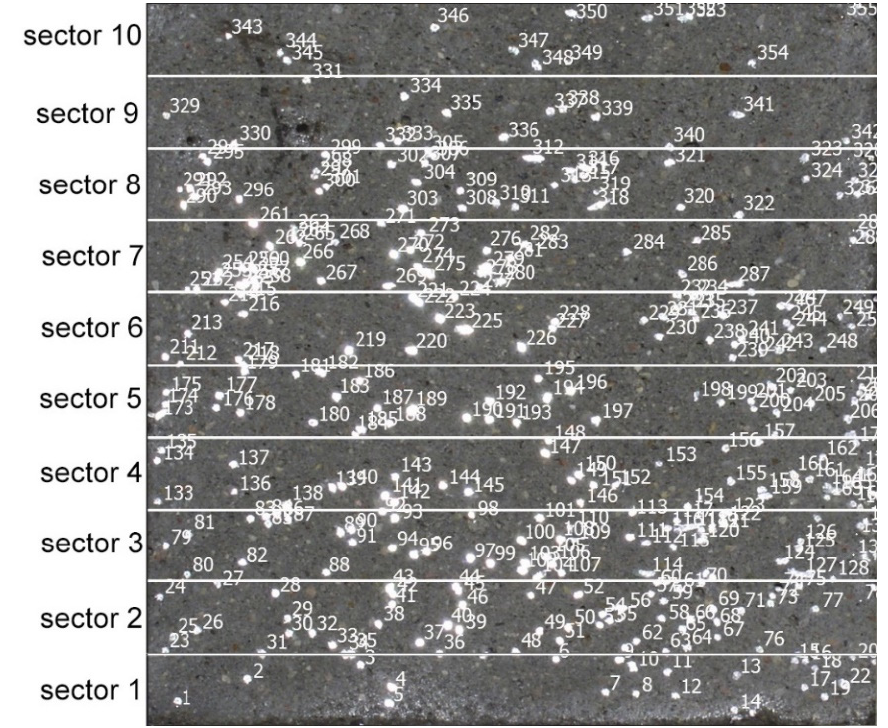
Figure 2. Exemplary cross-section of a SFRC specimen divided into 10 sectors with fibres counted. Table 3. The calculated parameters of four statistical distributions ensuring the best fit with experimentally tested fibre distribution along the vertical axis.